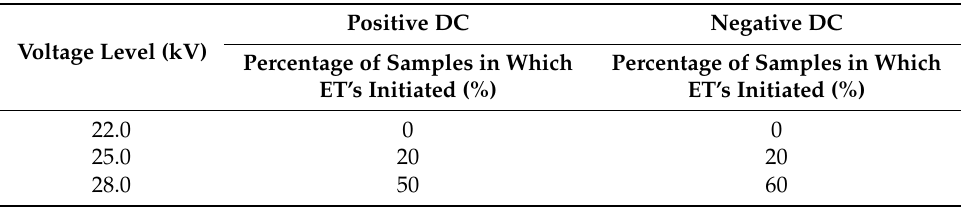
Table 2. Tree inception at non-continuous DC